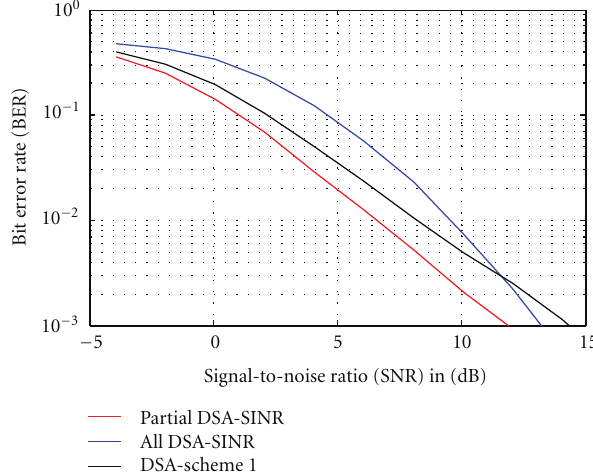
Figure 5: BER comparison between “Partial SINR” and “All SINR” schemes in a “default” uncorrelated channel.